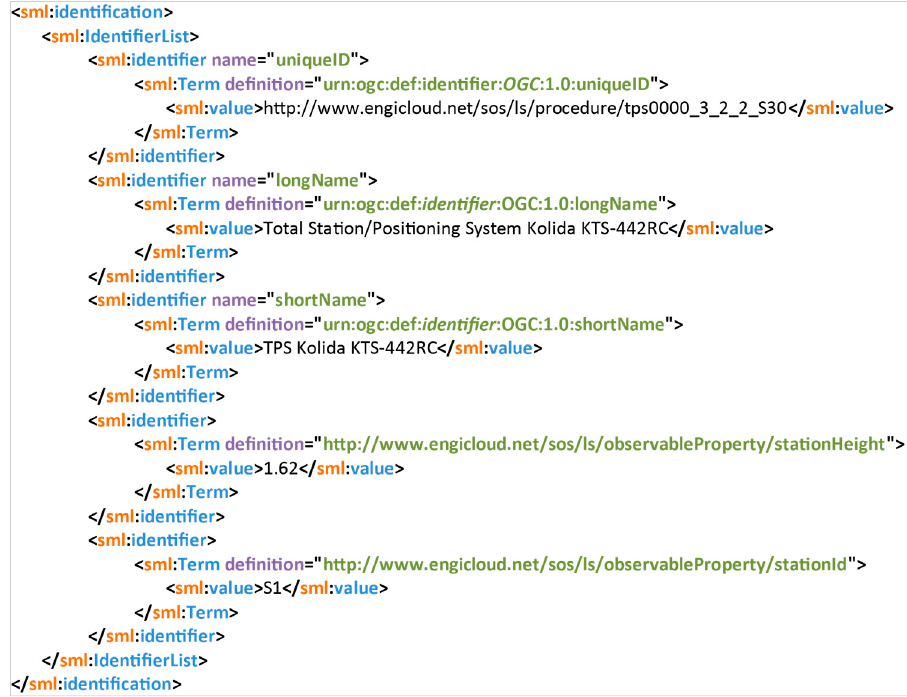
Figure 8. Insert sensor XML request, identification property (SOS-SML2.0).